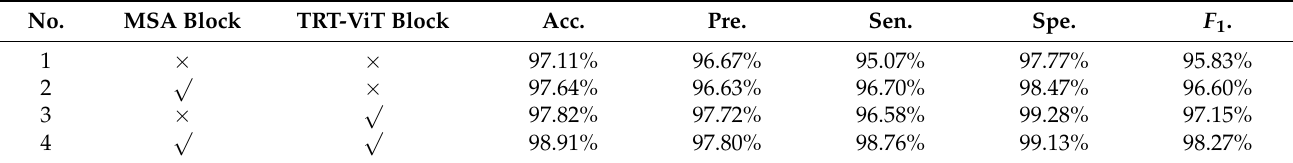
Table 9. Results of the ablation experiment on the COVID-19 Radiography database.